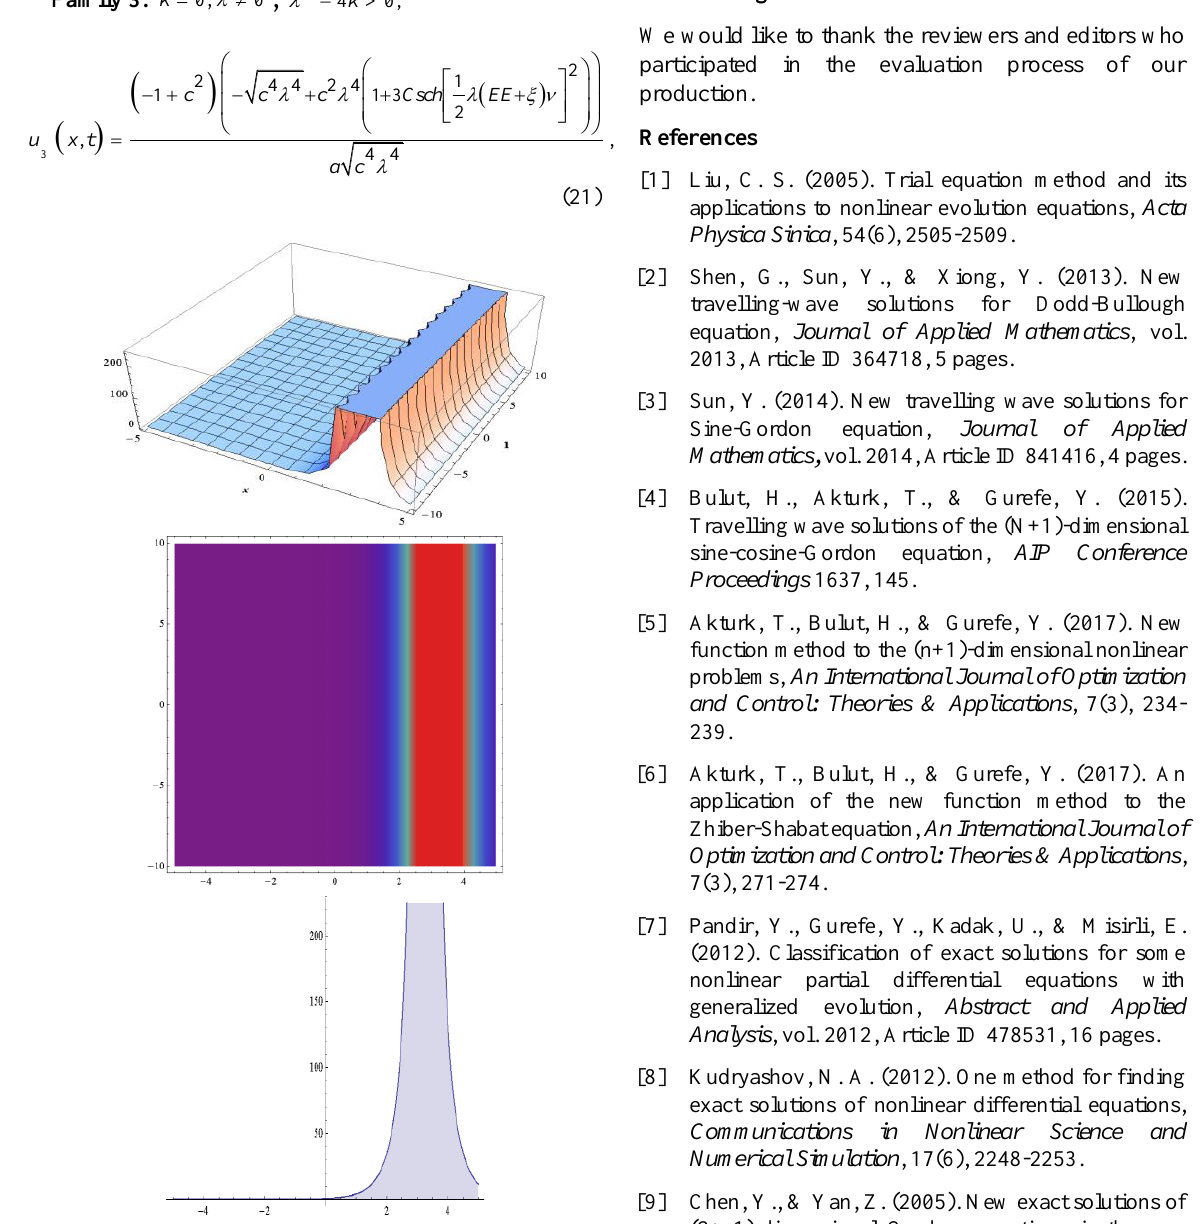
Figure-7. The 3D, density graphic and 2D surfaces of